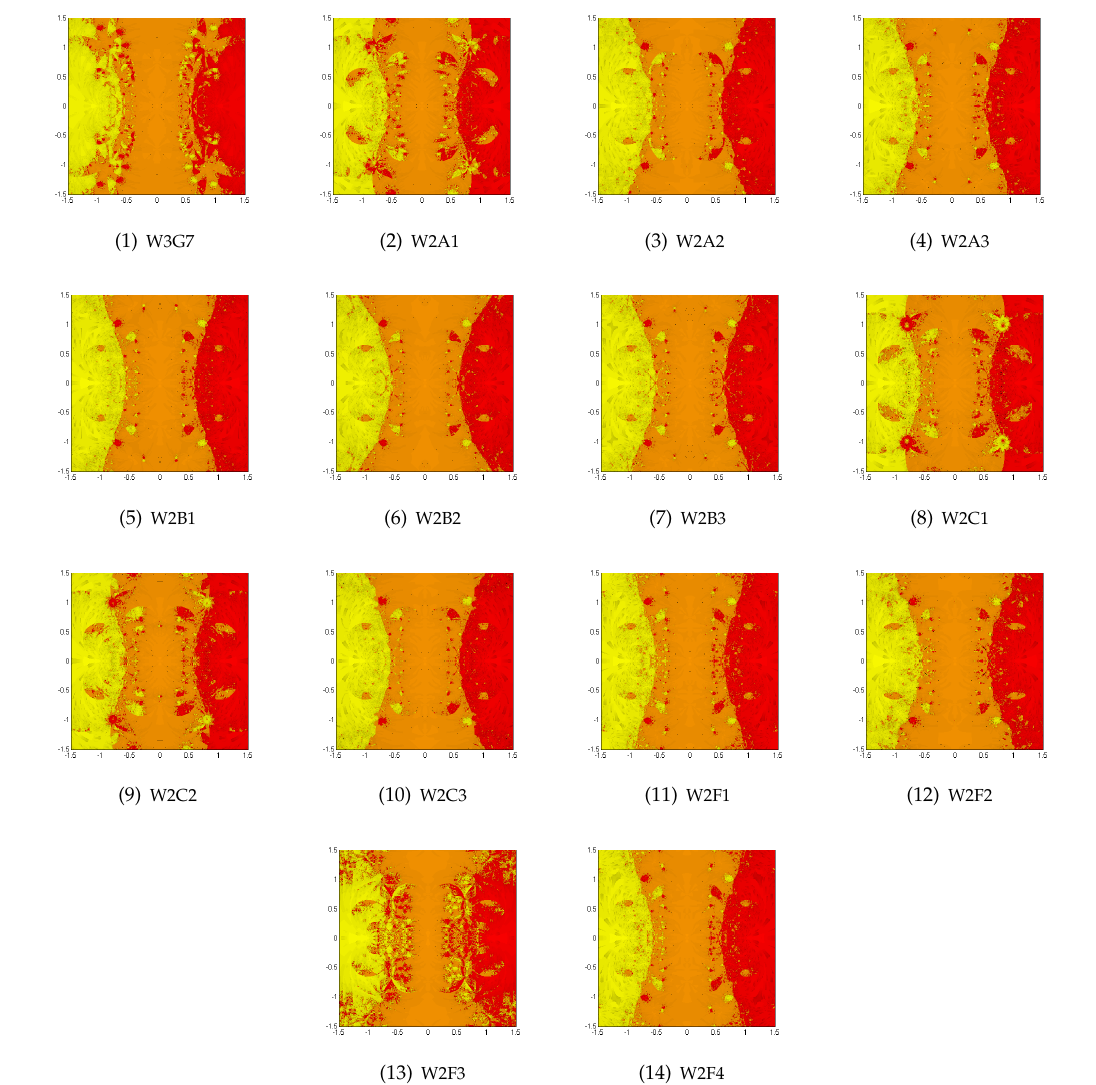
Figure 4. The top row for W3G7 ( left ), W2A1 ( center left ), W2A2 ( center right ) and W2A3 ( right ). The second row for W2B1 ( left ), W2B2 ( center left ), W2B3 ( center right ) and W2C1 ( right ). The third row for W2C2 ( left ), W2C3 ( center left ), W2F1 ( center right ) and W2F2 ( right ). The bottom row for W2F3 ( left ) and W2F4 ( right ), for the roots of the polynomial equation ( z 3 − z ) 4